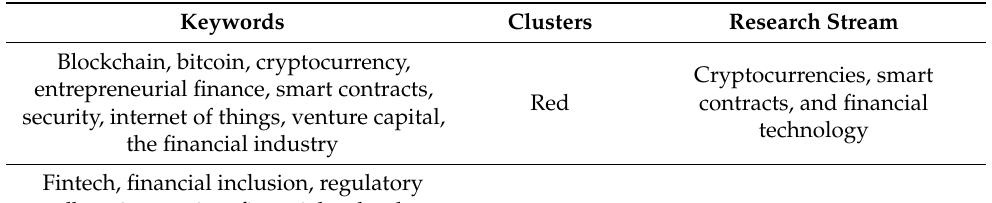
Table 5. Research stream of Fintech